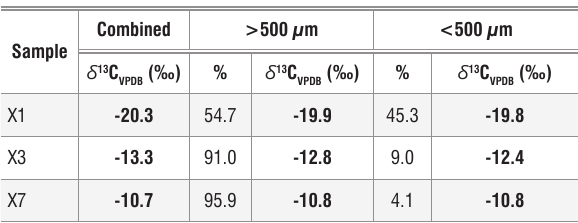
Dotted lines indicate endpoints for (1) xylitol; mean maize (corn) Zea mays δ 13 C=-12.4‰, includes seeds and cob values 48,50-53 , mean birch Betula pendula δ 13 C=-28.5‰, includes leaves and wood 54-58 and (2) sugar; mean sugarcane Sacharrum spp. δ 13 C=-12.7‰ 41,48 , mean sugar beet Beta vulgaris δ 13 C=-25.6‰ 41,59 . *indicates laboratory samples. For xylitol samples: Xy indicates xylose samples (grey markers), similar numbers indicate same brand name. For sugar samples: sucrose unless indicated; F, fructose; G, glucose. Grey sugar markers indicate Agave (CAM photosynthesiser) derived sugars; similar numbers indicate same brand name; open sugar markers indicate sugar samples derived from coconut blossom. Figure 1: The δ 13 C values of 29 xylitol, 3 xylose and 29 sugar samples. See Supplementary tables 1 and 2 for isotope values of samples presented in the figure, and values and references for calculated mean endpoint values for xylitol and Table 1: δ 13 C values of different xylitol granule size components (>500 μm and <500 μm), with proportions (%) of each size category indicated